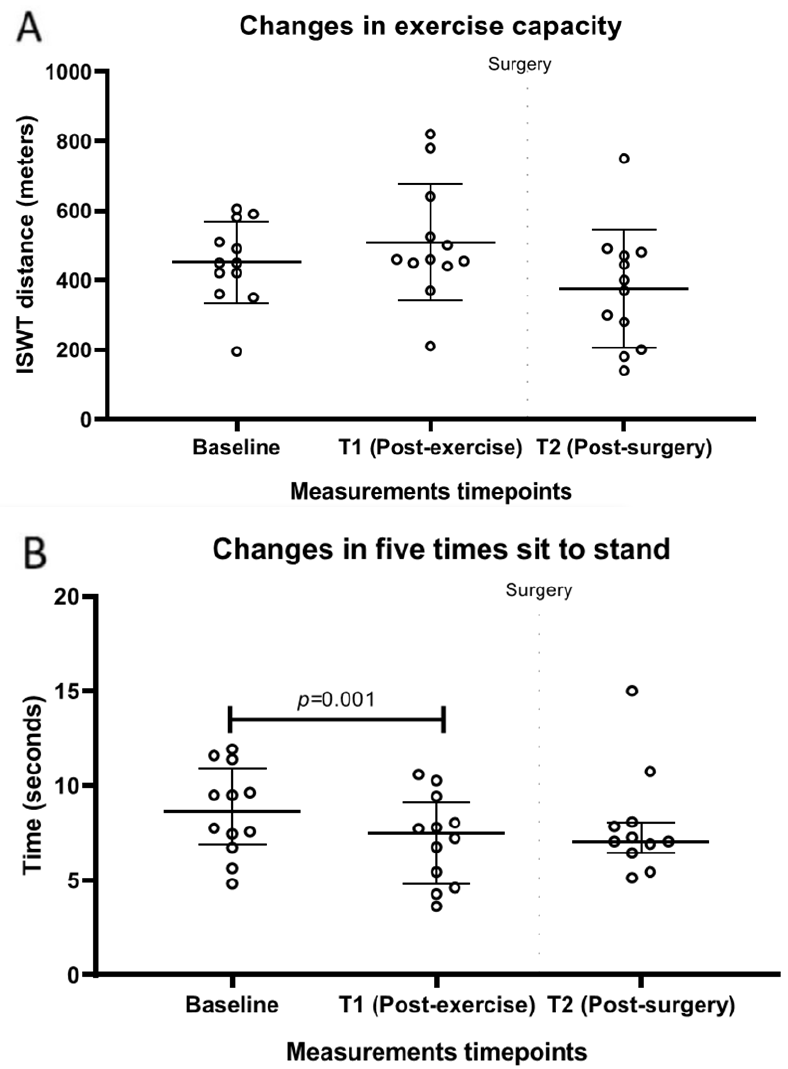
Figure 4. Changes in physical performance: ( A ) exercise capacity; ( B ) five-times sit-to-stand.